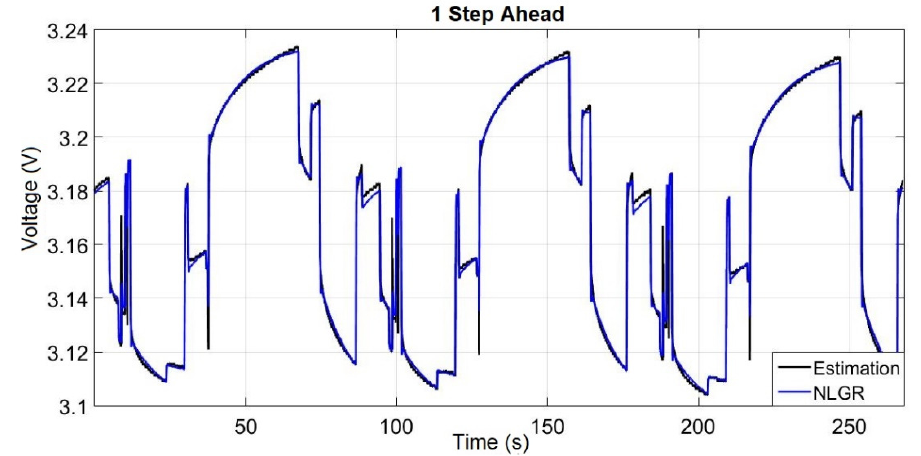
Figure 14. One-step ahead prediction with the best experiment design.